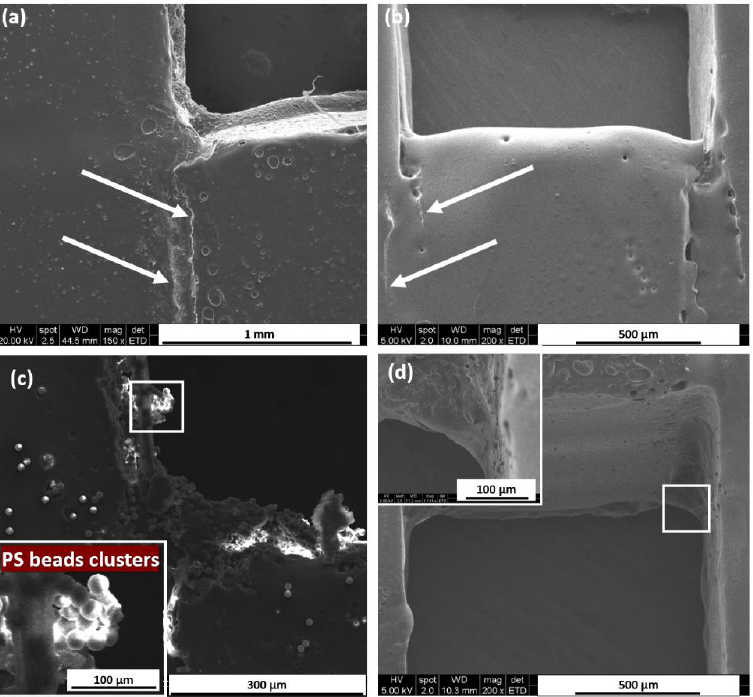
Figure 6. Surface roughness characterized by SEM. Images of cross-sections of PbLT-fabricated microfluidic chips ( a ) without hydrophobic treatment and ( b ) with hydrophobic treatment. The dashed line indicated by arrows on ( a , b ) shows the boundary between the PMMA substrate and Parafilm ® . ( c ) Microchannel without hydrophobic treatment after infusion of PS beads. Obvious clusters were observed on the channel surface, especially at the corners. ( d ) The adhesion of 10 μm PS beads to the channel surface was significantly reduced by hydrophobic treatment.